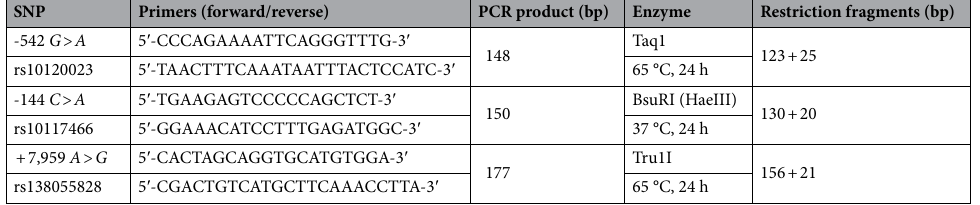
Table 5. Sequences of primers, lenghts of PCR products/restriction fragments and corresponding restriction enzymes, used for PCR–RFLP procedures for investigation of selected FCN1 gene single nucleotide